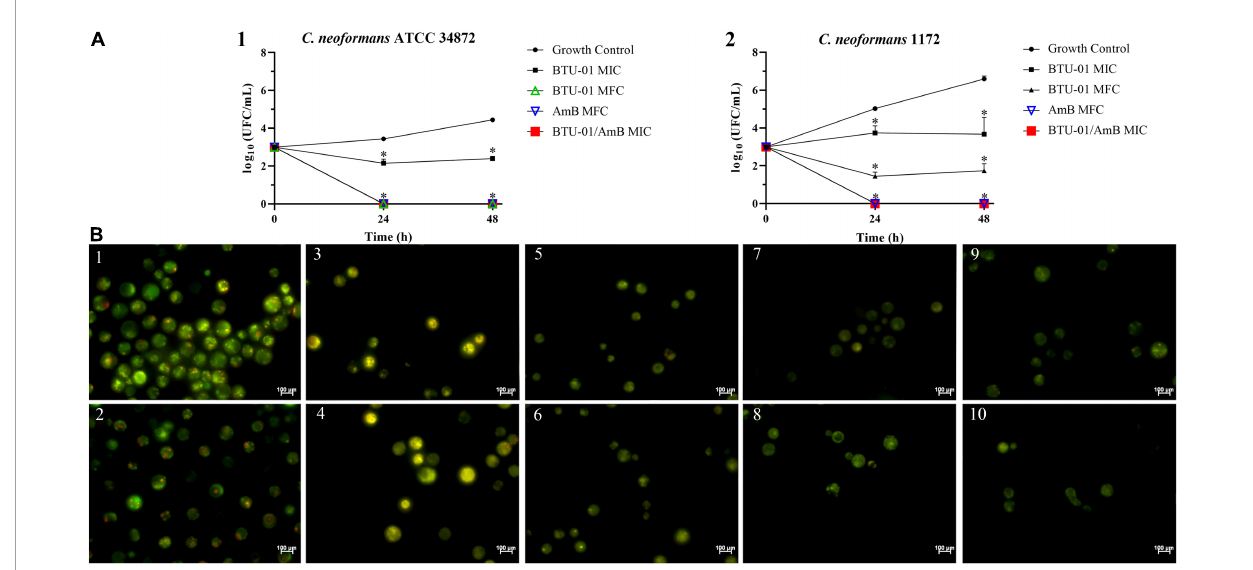
FIGURE3 Synergistic antifungal interaction of N -(butylcarbamothioyl) benzamide (BTU-01) and amphotericin B (AmB) in Cryptococcus neoformans . (A) Time-kill kinetics of BTU-01, AmB and their synergistic combination. (1) C. neoformans ATCC 34872; (2) C. neoformans 1172. The log 10 CFU/mL values were the mean and the standard deviation representative of three independent experiments. ∗ p < 0.05. (B) Cell viability analysis of C. neoformans ATCC 34872 (1, 3, 5, 7, and 9) and C. neoformans 1172 (2, 4, 6, 8, and 10) after differential labeling with FUN TM -1 dye. Yeasts were incubated with or without the MICs and MFC of the two compounds alone or combined for 12 h. Cells with diffuse greenish-yellow fluorescence characterize metabolically inactive cells and cells containing red fluorescent intravacuolar structures represent metabolically active yeast. (1 and 2)